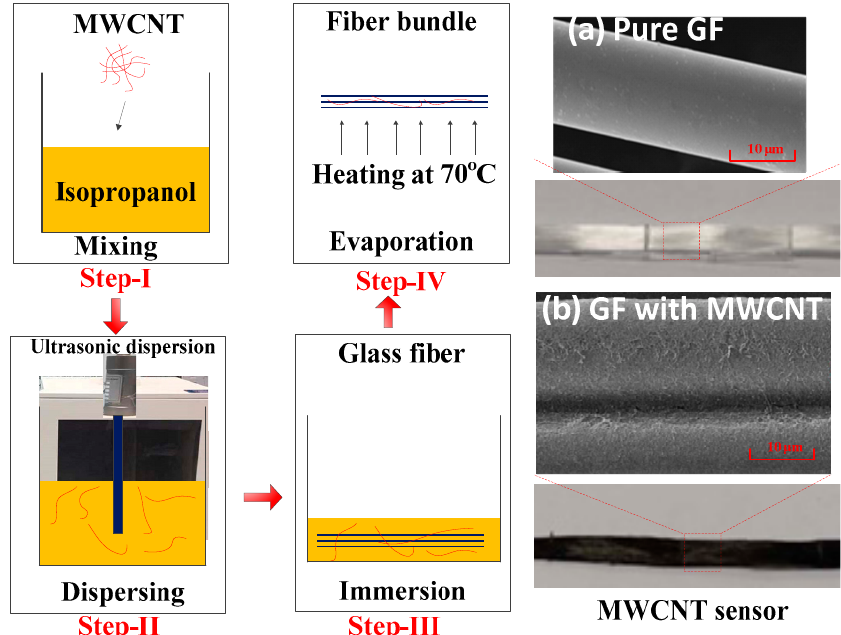
Figure 1. The manufacture processing of multi-walled carbon nanotube (MWCNT) sensor and its microcosmic appearance on a glass fiber (GF) bundle surface: ( a ) is the pure GF surface, while ( b ) is the GF fiber with MWCNT.